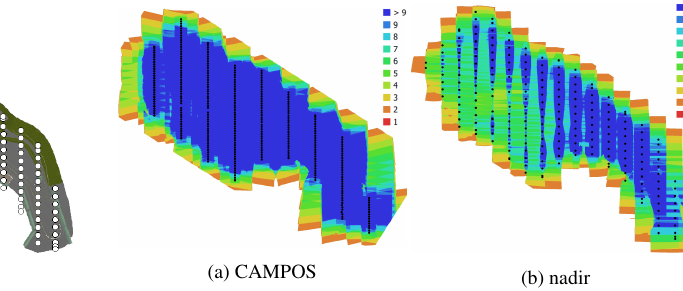
Figure 7. Overlap of photos with each survey